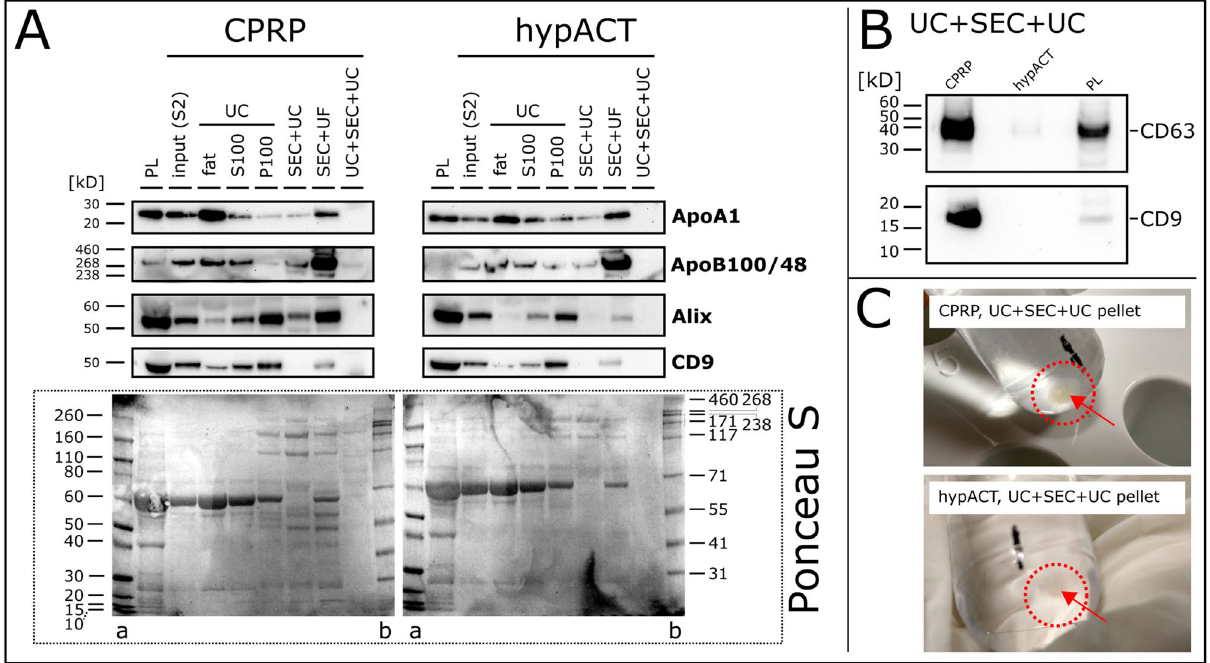
Figure 3. Western Blot of lipoprotein (ApoA1, ApoB100/48) and EV markers (Alix, CD9, CD63). ( A ) 10 µg protein was loaded per lane (except for PL, 20 µg) and membrane Ponceau S stained after transfer is shown. ( B ) Detection of CD63 and CD9 (80 µg per lane, except for 20 µg for PL) in UC + SEC + UC pellets. ( C ) UC + SEC + UC pellets obtained after removing supernatant. PL: platelet lysate, S2: plasma or serum supernatant after 2500 × g centrifugation, S100: supernatant after 100,000 × g centrifugation, P100:.pellet after 100,000 × g centrifugation, fat: buoyant layer after ultracentrifugation, a: marker (Invitrogen, #LC5800), b: marker (Invitrogen, #LC5699). Full-length blots/gels are presented in Supplementary Data